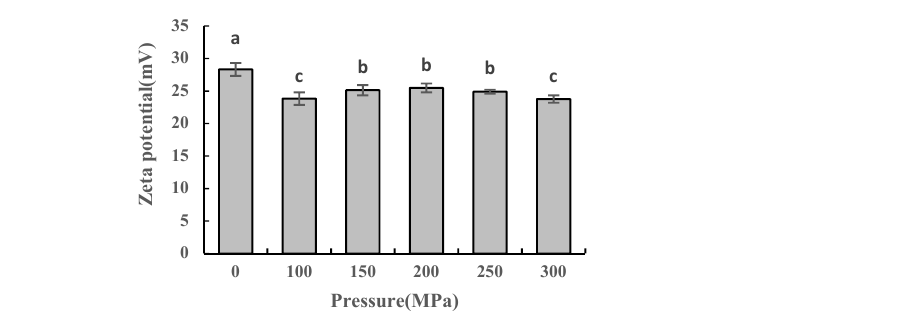
Figure 5. Zeta potential of casein under different pressure conditions. Different superscript letters within a column indicate significant differences between means ( p < 0.05).